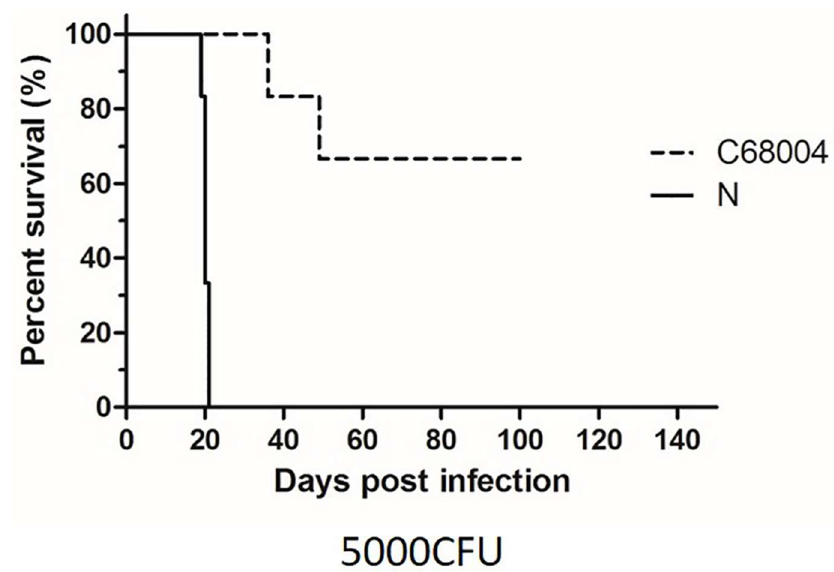
Figure 2. The survival rates of mice infected with 5000 CFU of M. bovis N and M. bovis C68004 strains. Each group had six mice. Observation times (day post-inoculation) are indicated in the x -axis. The experiment was repeated two times independently.